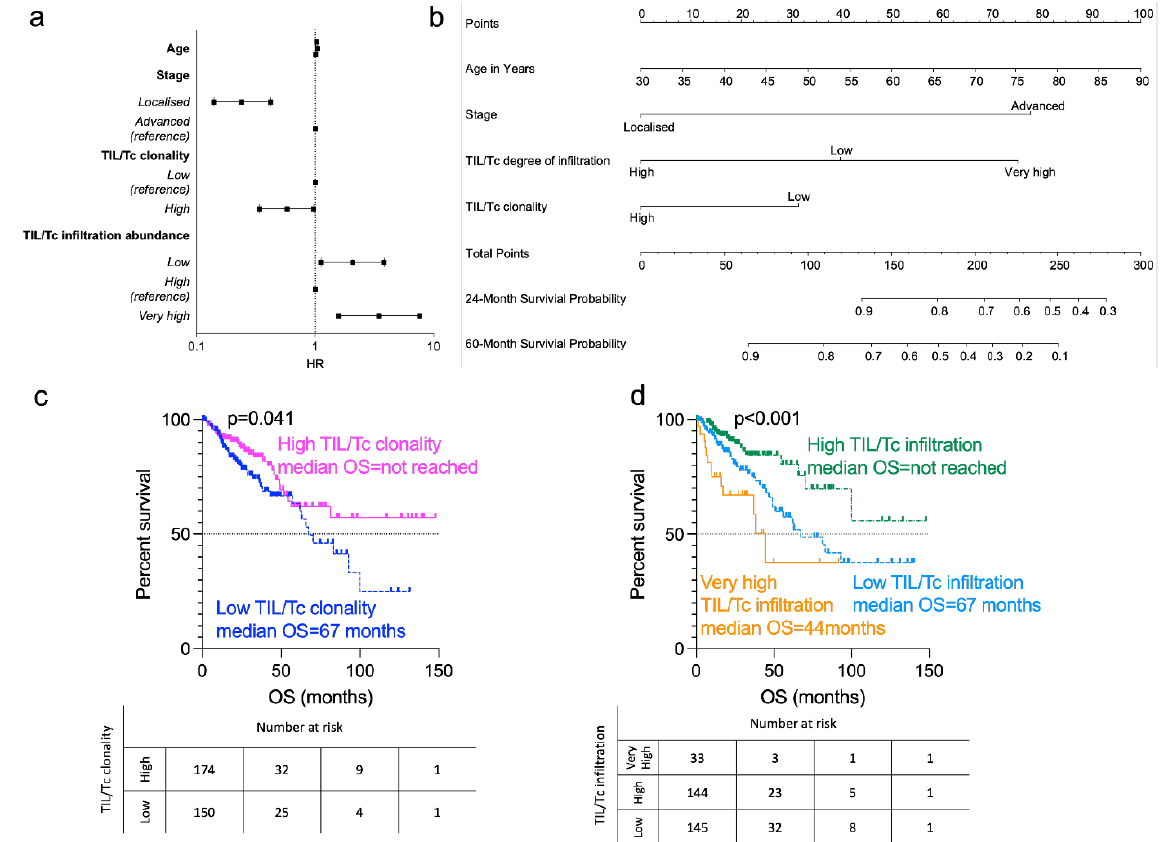
Figure 1. Prognostic factors for overall survival in patients from The Cancer Genome Atlas colorectal cancer cohort. ( a ) Forest plot showing hazard ratio (HR) for mortality with 95% C.I. for significant covariates retained in the multivariable Cox regression prognostic model calculated using the fast– backwards method and the Akaike information criterion as a stopping rule and summarised in Supplementary Materials Table S1 (cases = 337, Cox model for OS global p < 0.001). Age, HR 0.03, p < 0.0001; stage (localised), HR 0.34, p < 0.0001; TIL/Tc clonality (high), HR 0.86, p = 0.002; TIL/Tc infiltration (low), HR 0.55, p = 0.011; TIL/Tc infiltration (very high), HR 1.43, p < 0.001. ( b ) Derived nomogram for survival probability integrating clinical variables and TIL/Tc features. ( c ) Survival curves for patients with high (pink) or low (blue) TIL/Tc clonality (log-rank p = 0.041). ( d ) Survival curves for patients with “ low ” (blue), “ high ” (green) or “ very high ” (orange) TIL/Tc abundance (log-rank p < 0.001).